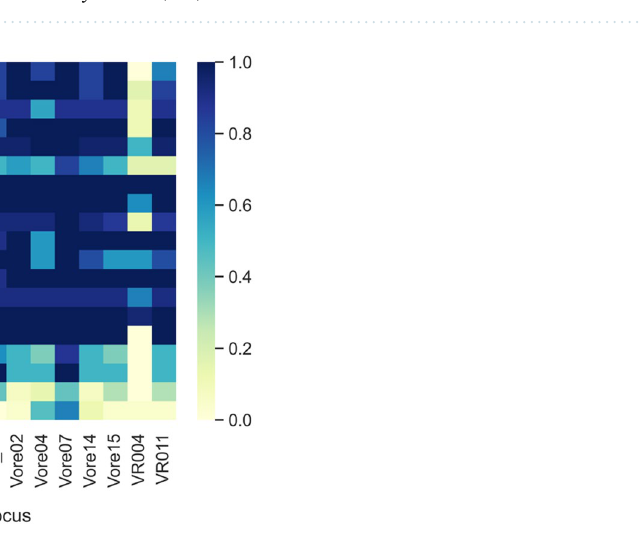
Figure 3. Overall expected and spurious amplification frequency percentages for all 49 SSR markers. Expected amplification is shown in grey. Spurious amplification is shown in color. Yellow represents the Viburnum dilatatum (VD) markers, green represents the V. farreri (VF) markers, teal represents the Oreinotinus subclade (Vore) markers, and blue represents the V. rufidulum (VR) markers.